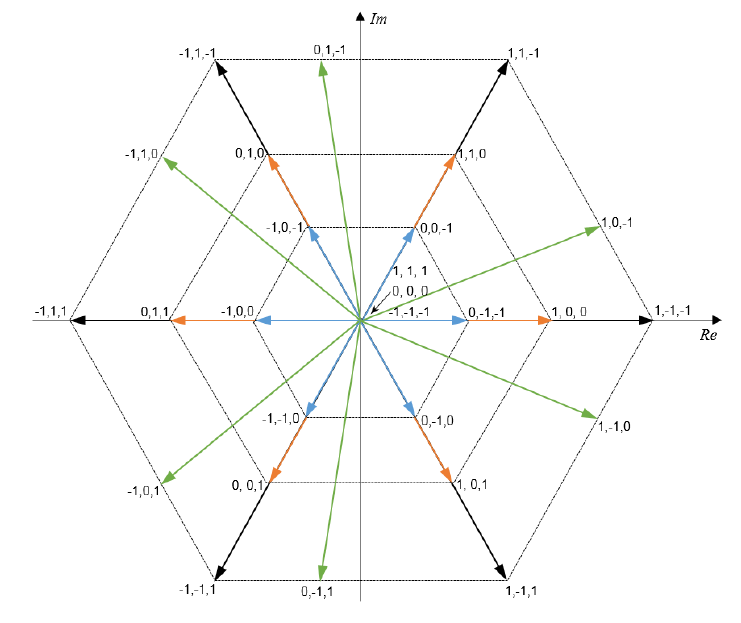
Figure 3. Voltage space vectors in case of unbalanced DC-link ( ∆ V = − V dc